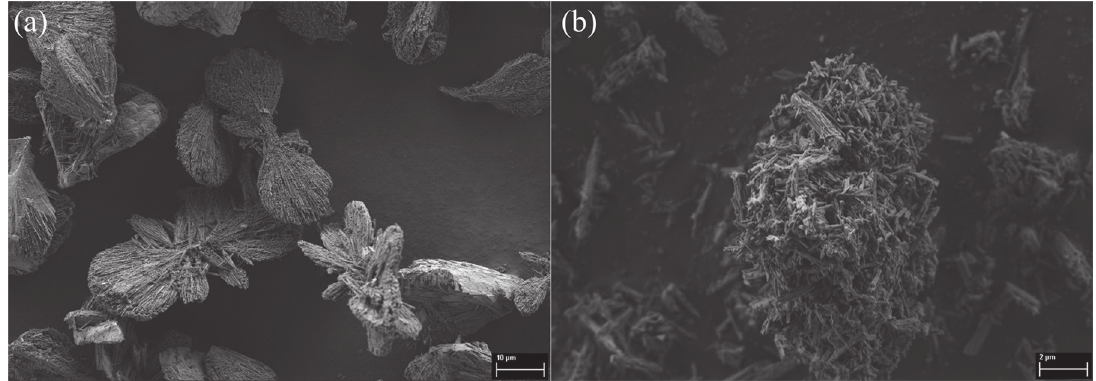
Figure 6: SEM images of samples prepared with ionic liquid by method A - (a) 7 days in static (TON-2) and (b) 3 days in stirring (TON-1). Table 2: Textural properties of the zeolites synthesized with ionic liquid.